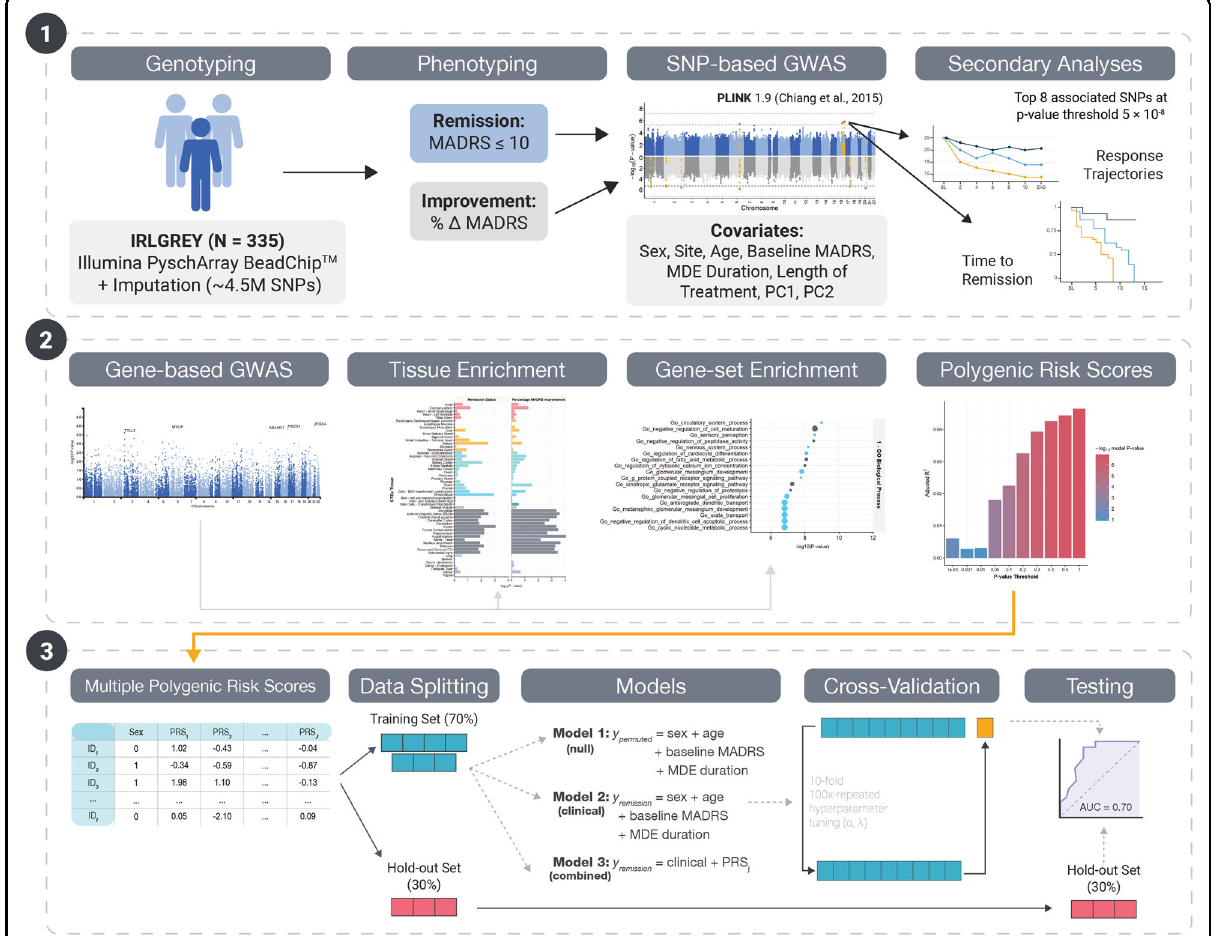
Fig. 1 Analysis work fl ow. The primary presented analysis is for the IRL-GREY European-ancestry sub-cohort ( n = 307). Results for the African-ancestry sub-cohort and total, mixed cohort are presented in the Supplementary